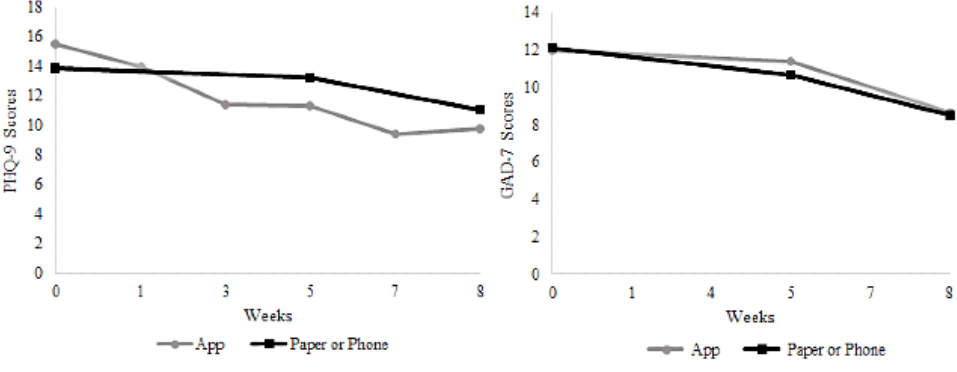
Figure 3. Mean depression and anxiety symptoms measured within the app and by paper or phone assessments. GAD-7: Generalized Anxiety Disorder 7-item; PHQ-9: Patient Health Questionnaire 9-item.